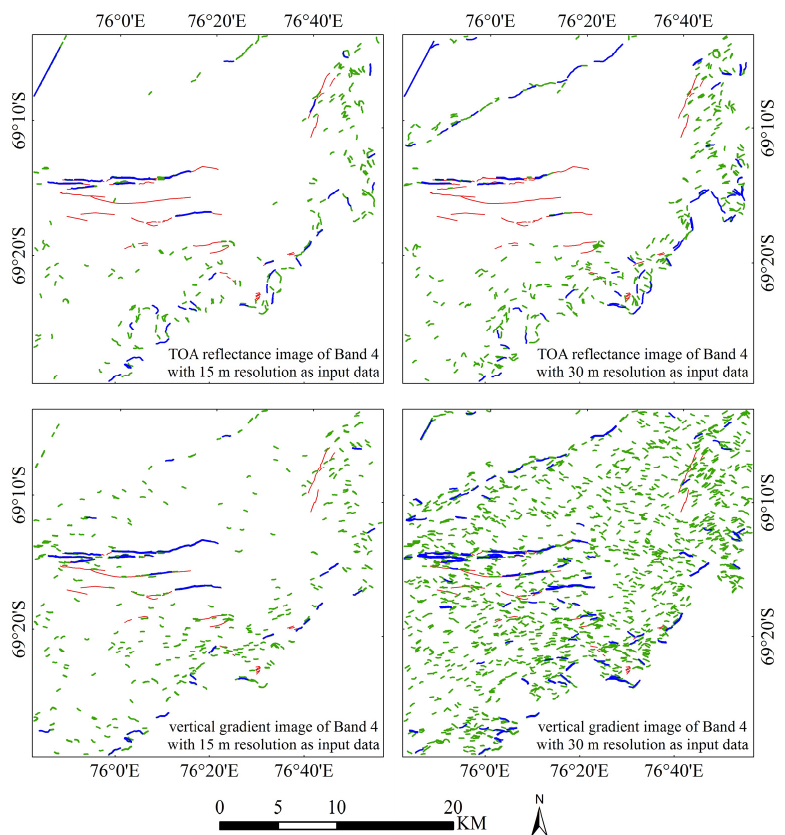
Figure 4. The detected lines output from the LINE module using Band 4 data with the two types of input data and the two resolutions. The blue lines have lengths longer than 1000 m and the leaf green lines have lengths ranging from 500 to 1000 m. Red lines are tidal cracks that were manually interpreted.